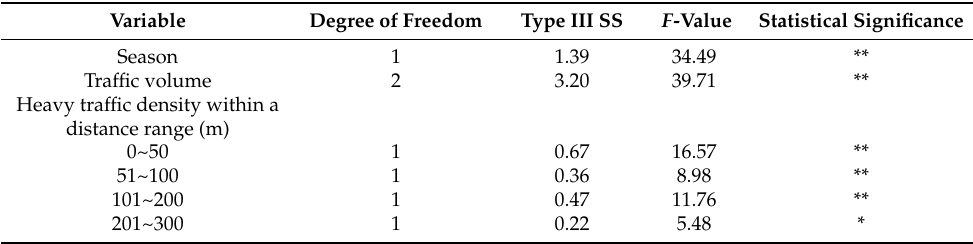
Table 4. General linear model (GLM) analysis on major factors affecting correlation between black carbon concentration and traffic density